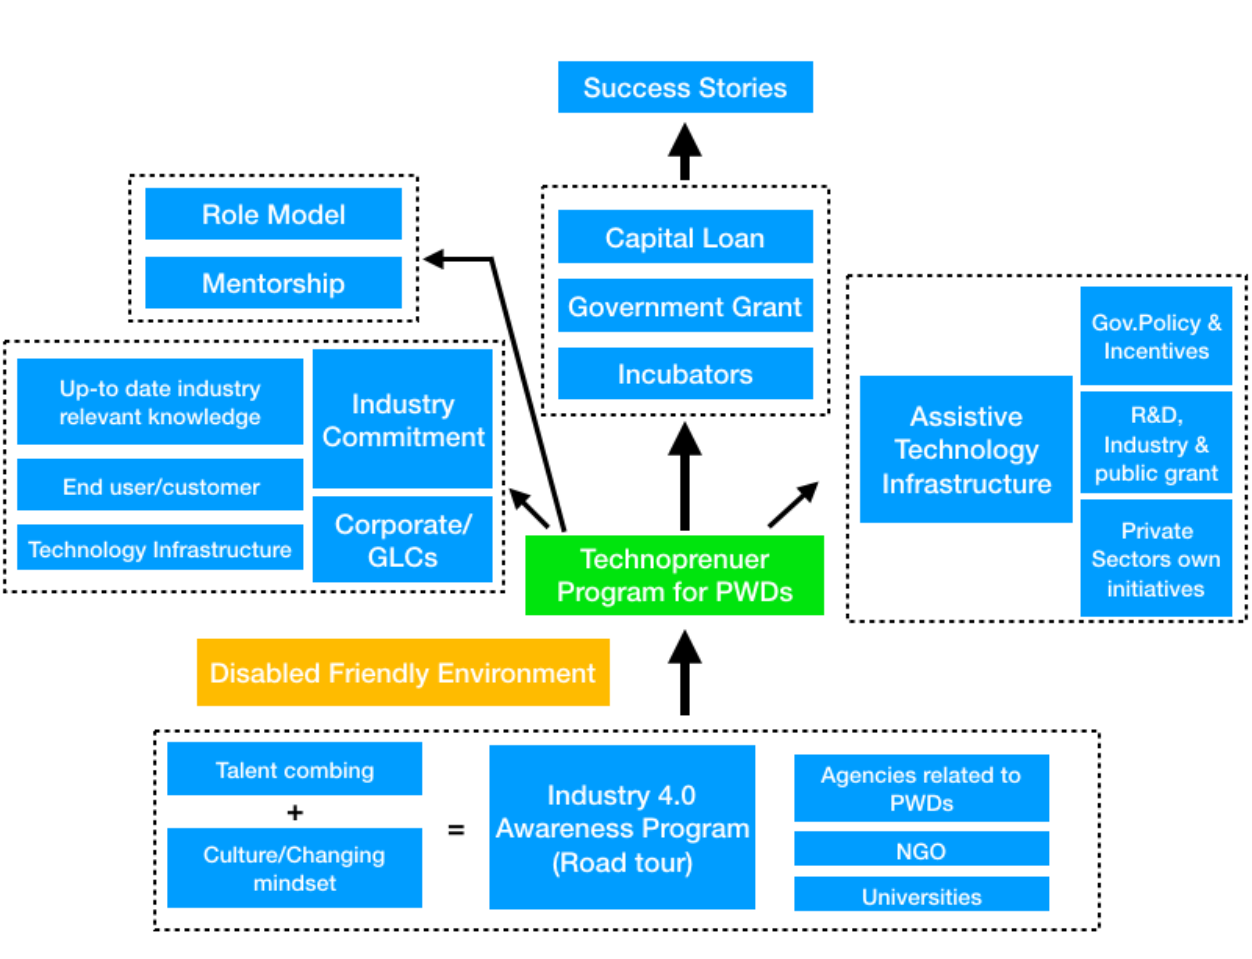
Figure 3. Proposed PWDs Technoprenuer Ecosystem